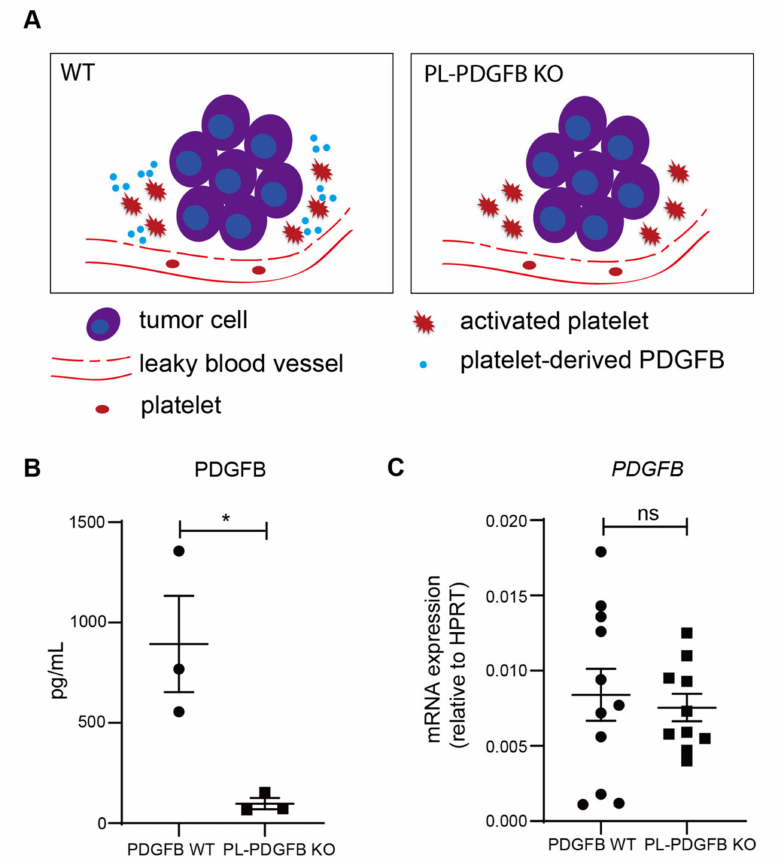
Figure 2. Reduced PDGFB levels in tumors from mice lacking PDGFB in platelets. ( A ) PDGFB is released from activated platelets in the TME in WT mice, but not in pl-PDGFB KO mice. ( B ) The amount of PDGFB protein in tumors derived from 14-week old WT and pl-PDGFB KO RT2-positive mice was analyzed using PEA in tissue lysates from whole tumors (WT n = 3; KO n = 3, * p = 0.0300). ( C ) Expression of PDGFB was analyzed by qPCR using RNA extracted from whole tumors from 14-week old WT and pl-PDGFB KO RT2-positive mice (WT n = 11; KO n = 10, p = 0.6776